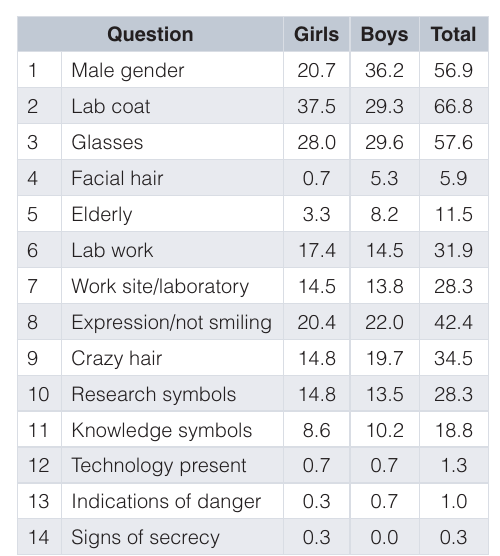
Table 2. Percentage of Draw-a-Scientist test stereotypes of scientists by gender. Based on data presented in